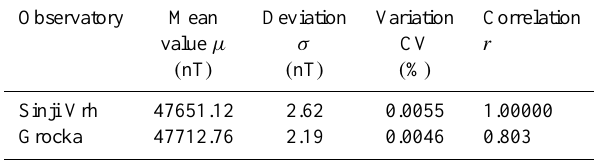
Table 1. Comparison of statistical values and the correlation of mea- surement results, obtained on 15 January 2013 at Sinji Vrh with those obtained at Grocka.